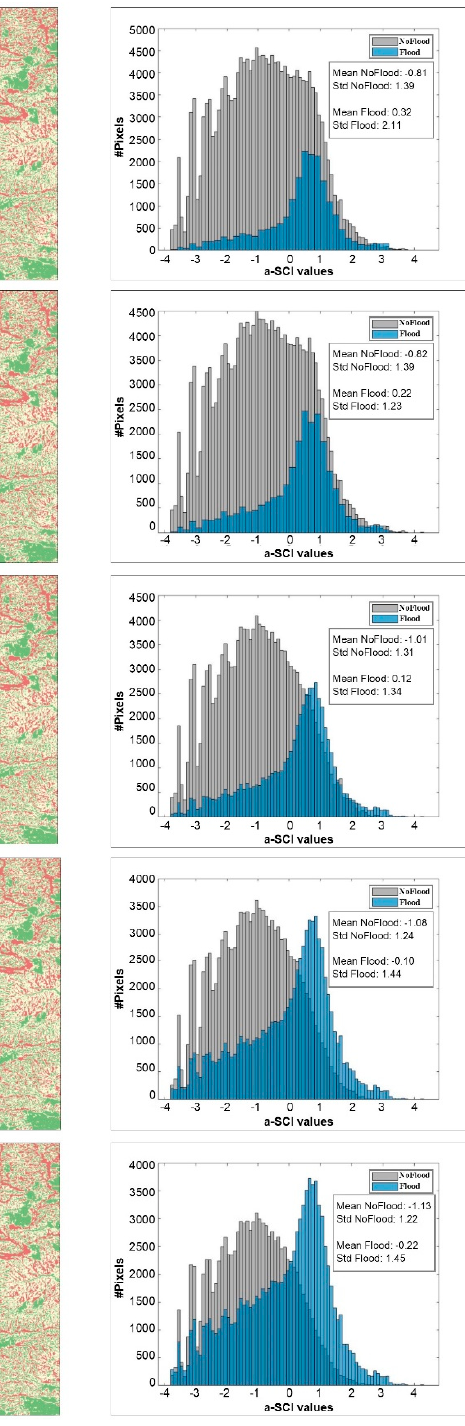
Figure 6. Histograms of a-SCI distributions for flooded and non-flooded areas, computed on a smaller area of the test site. Blue-bordered region: flooded area. Fuchsia-bordered region: buffer of 3000 m around the river course. ( a – e ) Flood and no flood areas in the considered flood events, observed ( a – c ) and predicted ( d , e ), ordered in increasing magnitude (maps on the left) and relative histograms (in blue and grey bins respectively, on the right).